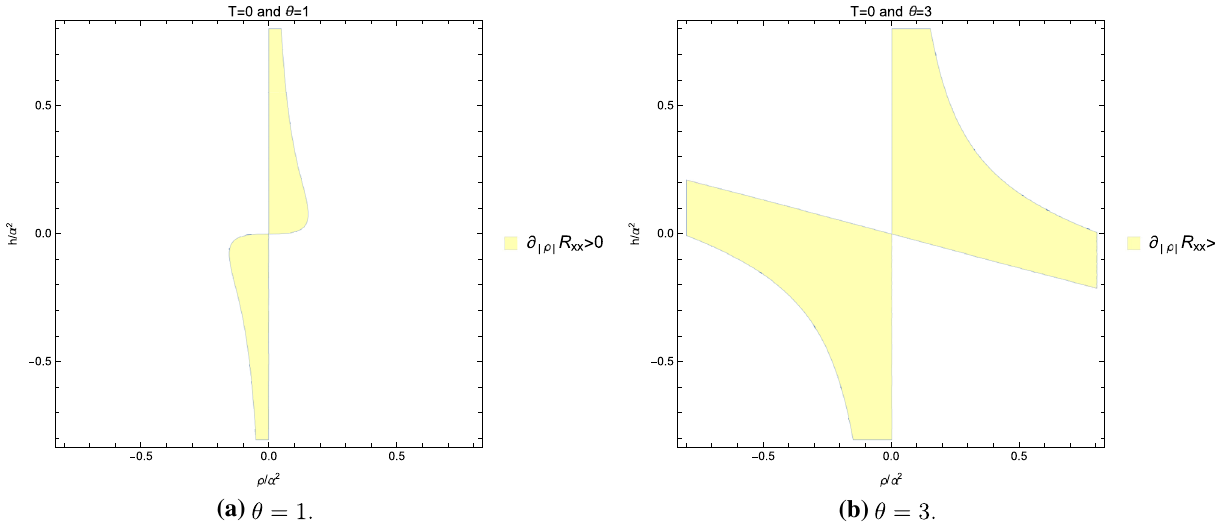
Fig. 5 Parameter space for ∂ | ρ | R xx > 0 in terms of ρ/α 2 and h /α 2 with θ = 1 and θ = 3 at T = 0 for Maxwell–Chern–Simons electrodynamics